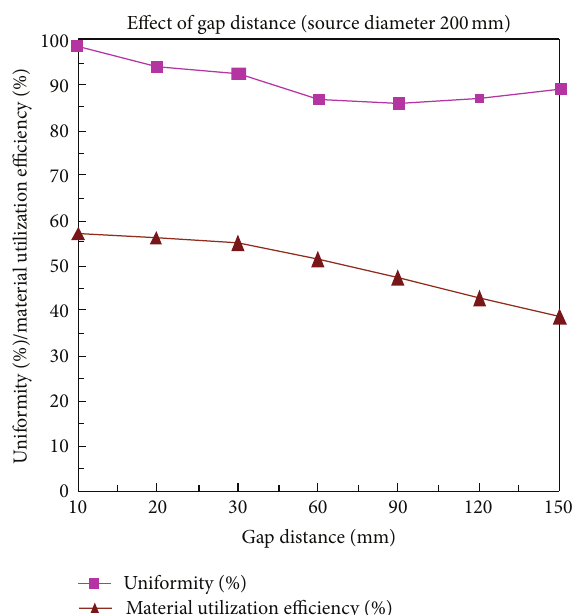
Figure 6: The relationship of thin-film uniformity and material utilization rate of Organic Material A at varying T/S gap distances. Subsequently, an electron-injection layer (EIL) of lithium fluoride (LiF) and aluminum cathode was deposited using thermal evaporation at 1.33 × 10 −3 Pa.